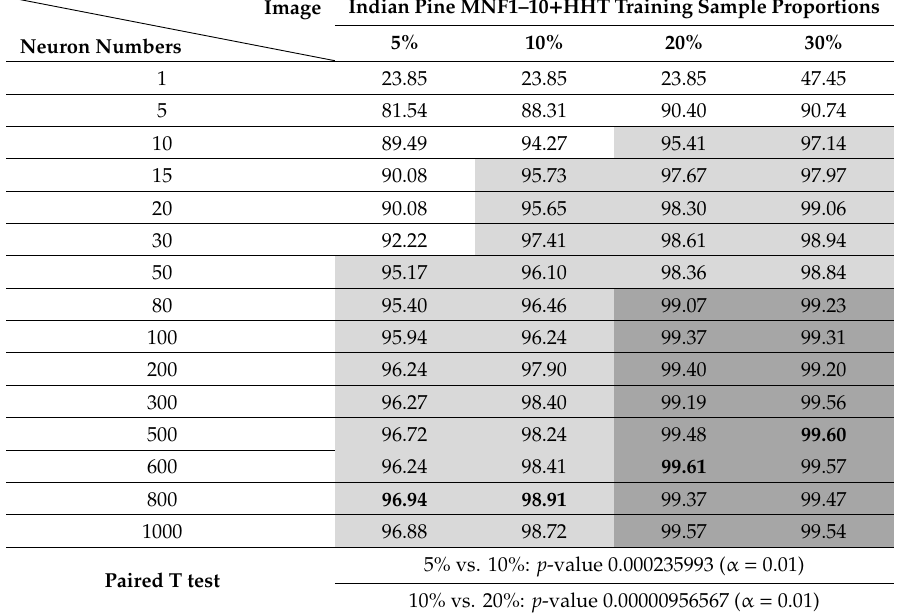
Table 1. Classification accuracy results of IP MNF1–10 + HHT image set with di ff erent training sample proportions using 1 to 1000 neurons. The highest accuracy value in the corresponding training sample proportion column is shown in bold, and values above 95% are shaded in light gray. In comparison, values above 99% are shaded in dark gray.